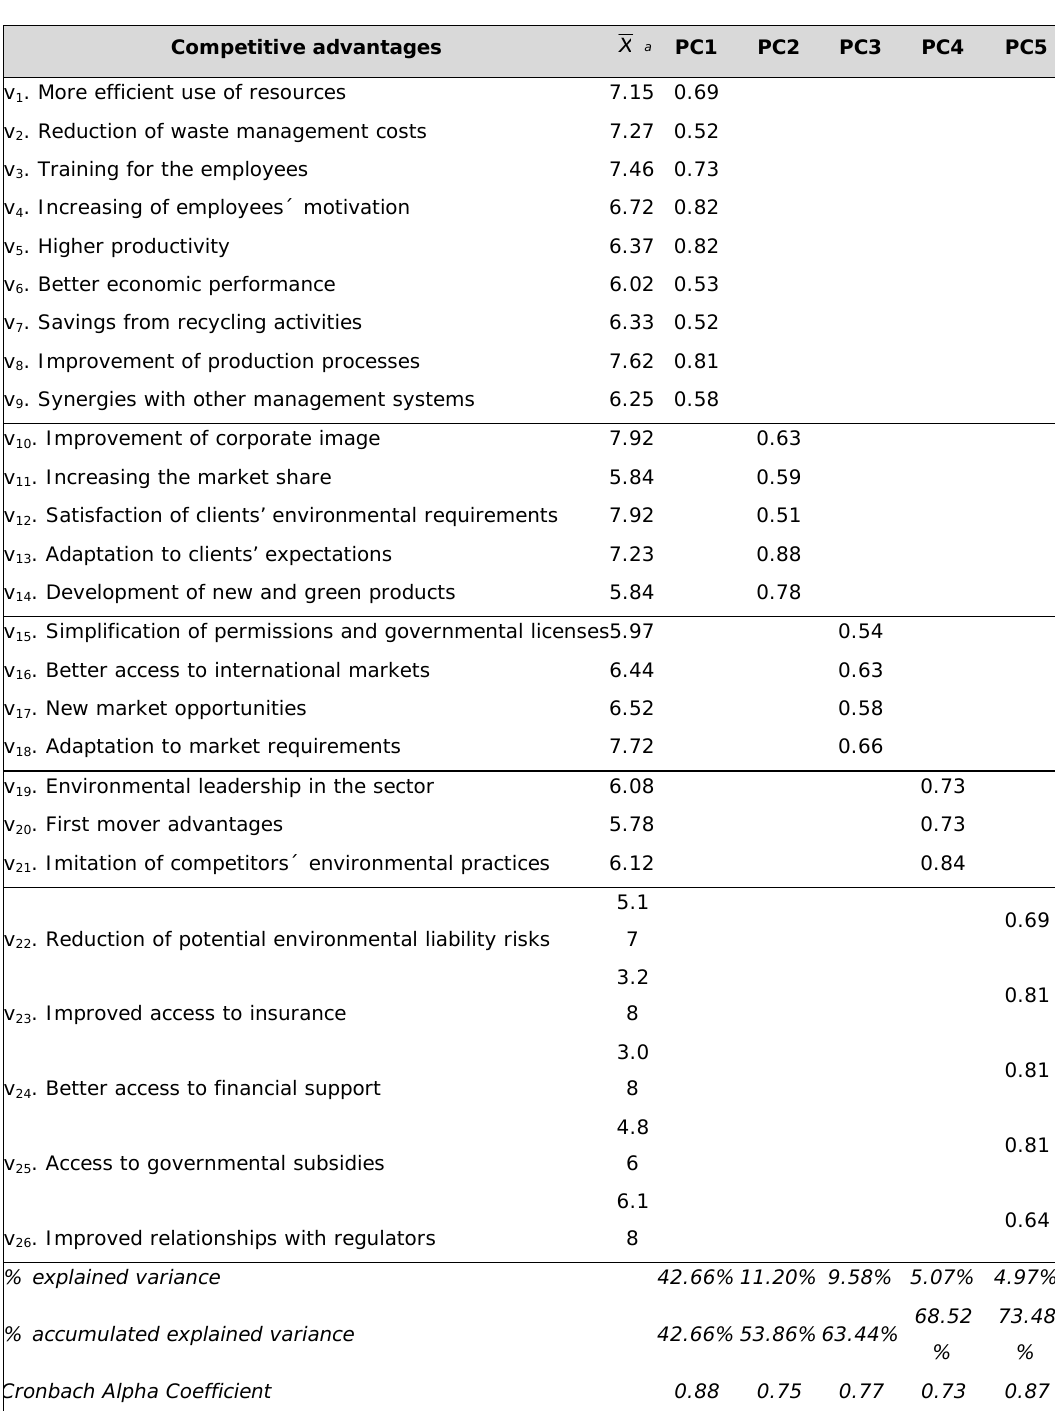
Table 2. “Competitive advantages-Principal Component